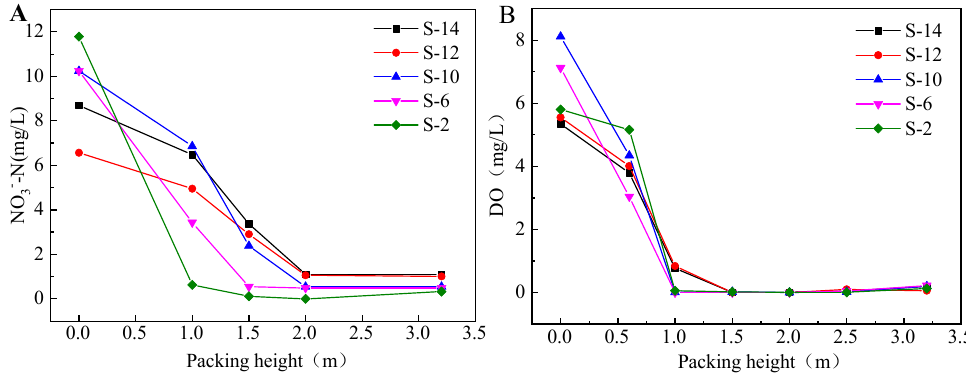
Figure 8. Nitrate ( A ) and DO ( B ) concentration variations in the pilot-scale bioreactor.